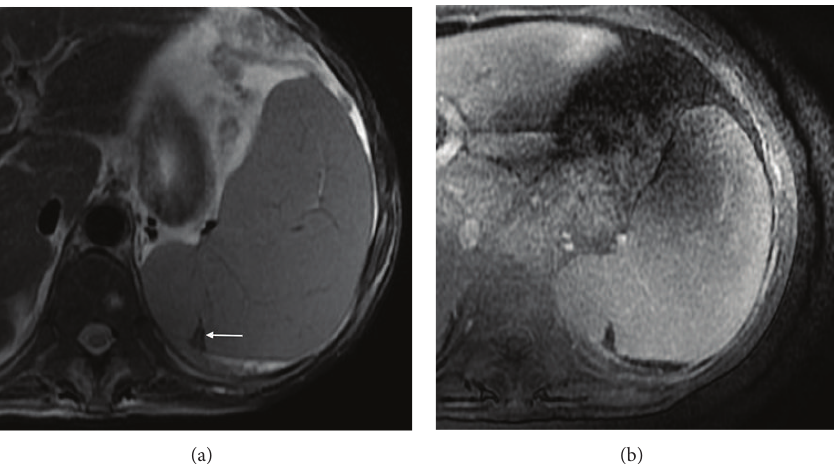
Figure 9: Splenic infarct. Axial T2wi FSE (a) and axial postcontrast fat-suppressed 3D-GRE T1wi at the venous (b) phase. A small triangular wedge-shaped area at the periphery of the spleen is noted (arrow, (a)), with hypointensity signal on both T1 and T2wi, with no enhancement on postcontrast images.